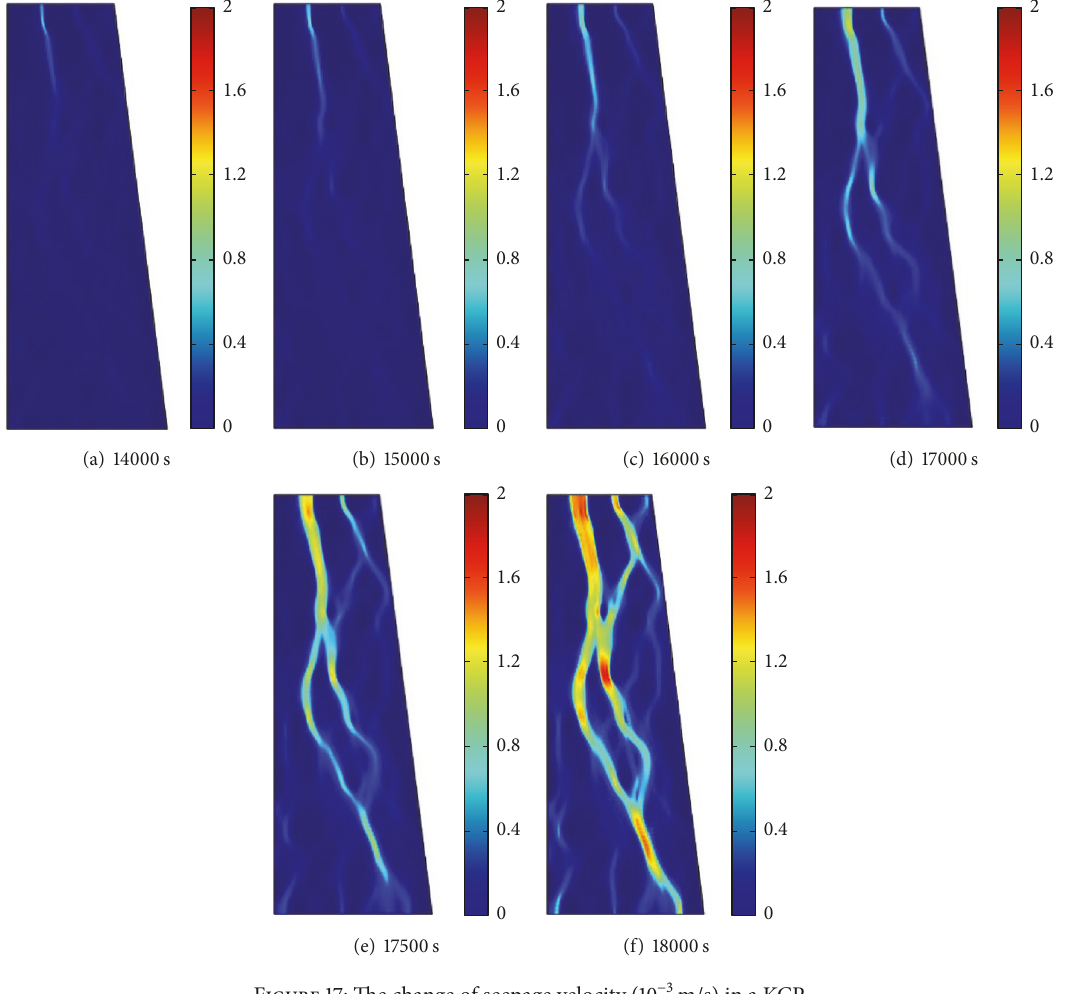
Figure 17: The change of seepage velocity (10 −3 m/s) in a KCP.